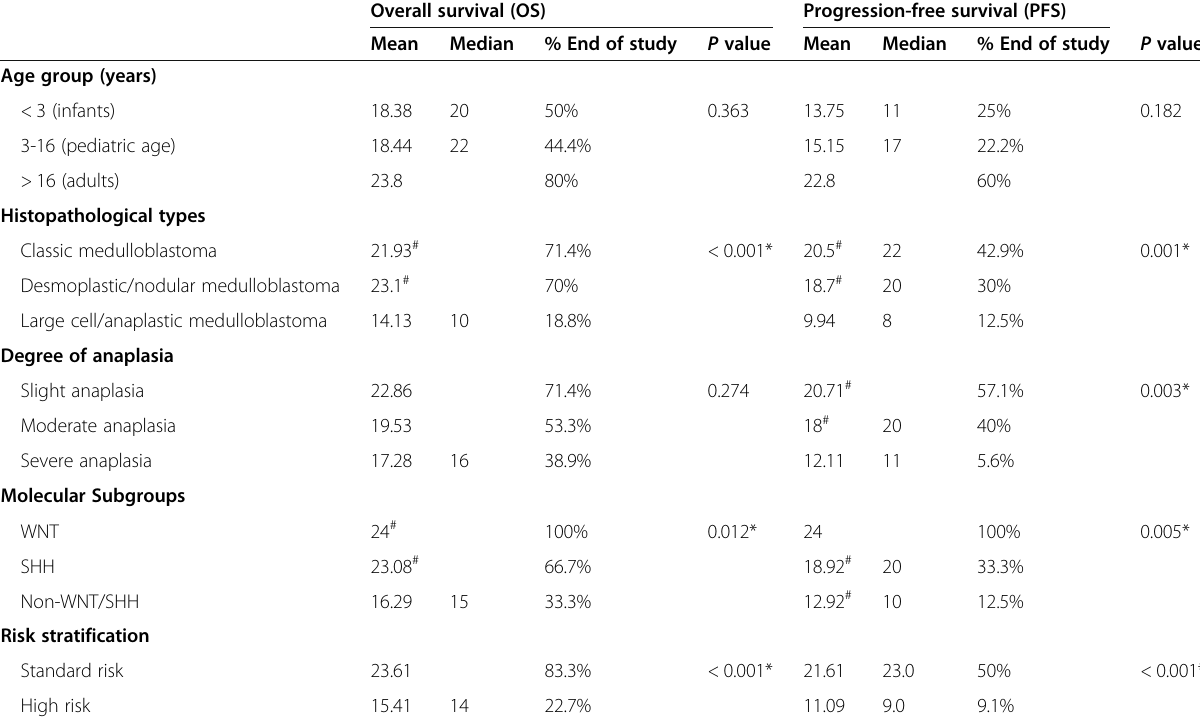
Table 6 Relation of overall survival (OS) and progression-free survival (PFS) to different clinicopathological parameters Overall survival (OS) Progression-free survival (PFS) Mean Median % End of study P value Mean Median % End of study P